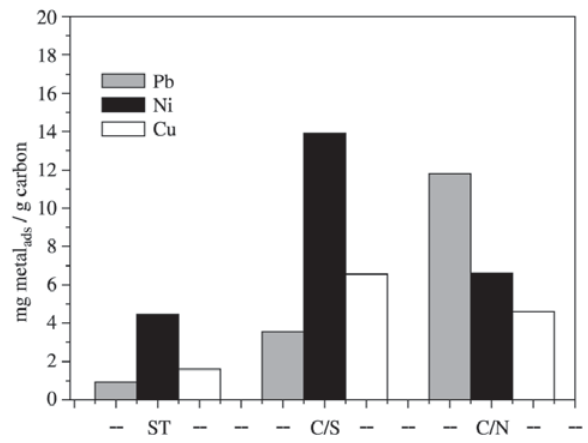
Figure 12. Adsorption of Pb +2 , Cu +2 and Ni +2 in aqueous solution on untreated carbon (ST) and on the EDT (C/S) and EDA (N/C) functionalyzed